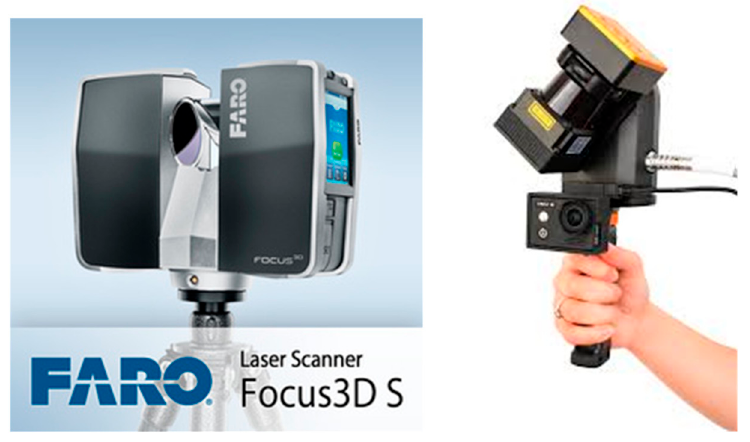
Figure 1. Faro Laser Scanner Focus 3D S (Left) by courtesy of www.faro.com; and GeoSlam Zeb-Revo (Right) by courtesy of https://geoslam.com.